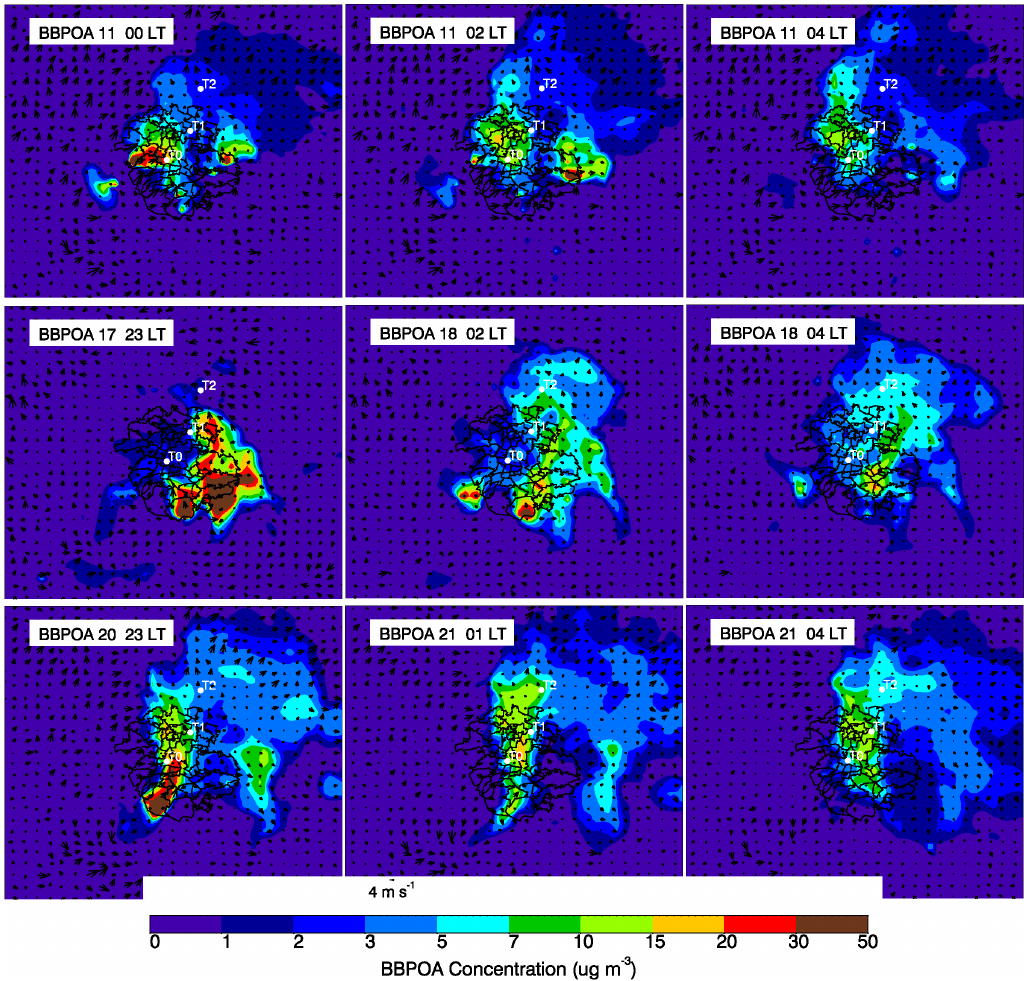
Fig. 7. Simulated BBPOA spatial distributions and their evolutions at nighttime. The date and local time is shown in the caption (e.g., 11 02LT means 11 March